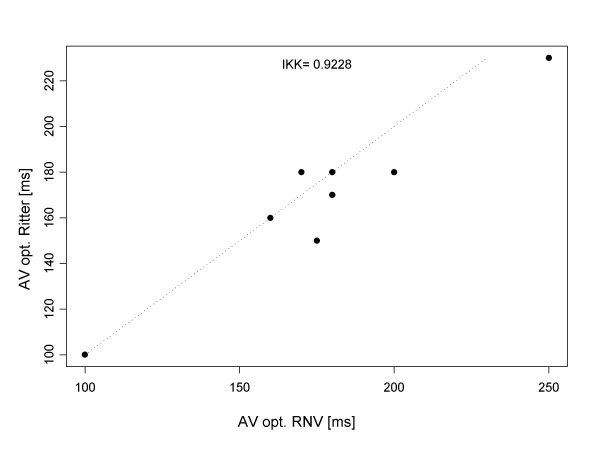
The correlation of the results of the RNV and Ritter methods, with respect to the optimal AV interval for Group 2.